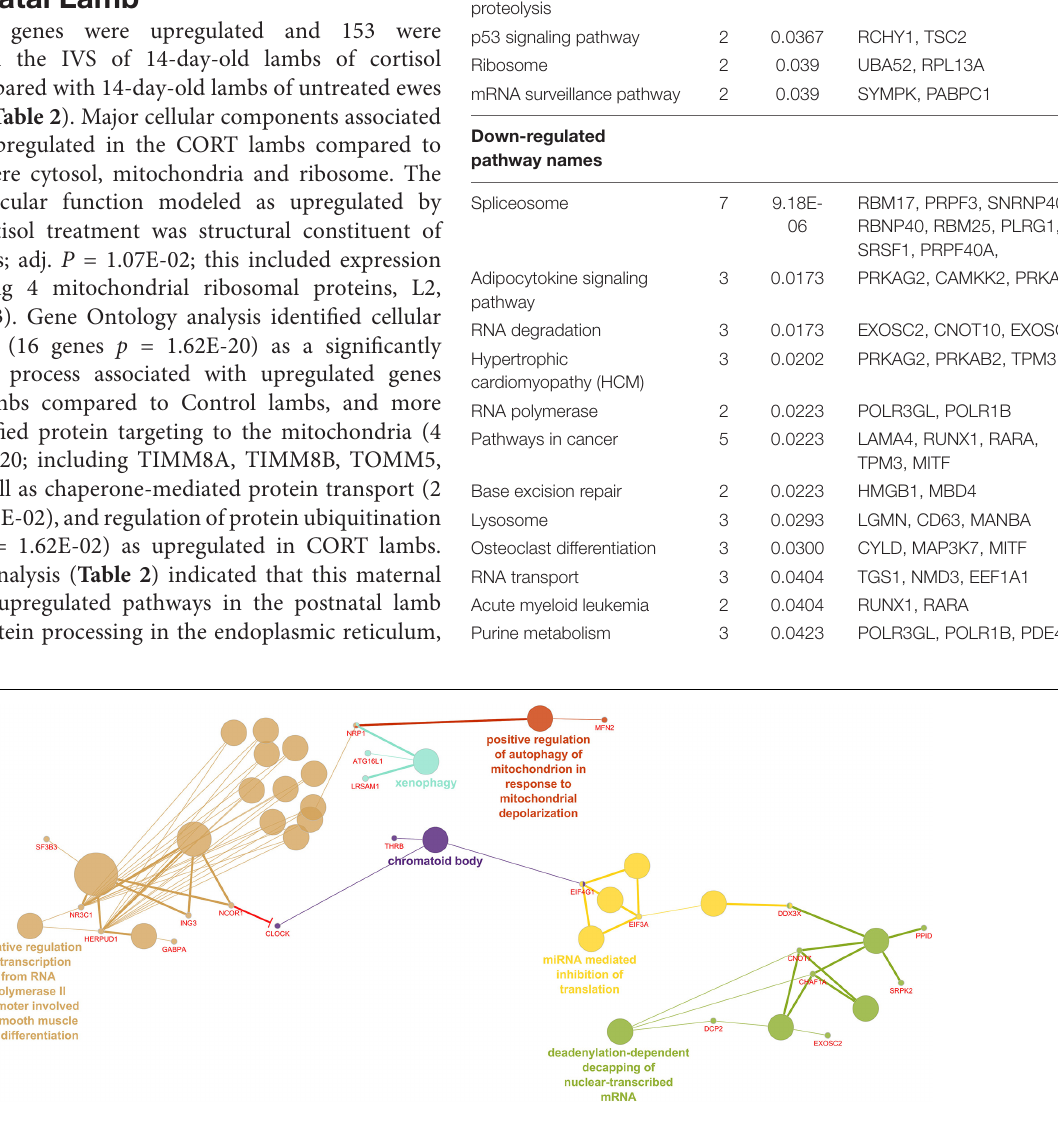
FIGURE 1 | Enriched ClueGO gene network from the left ventricular free wall. Similar gene ontology or KEGG pathway terms are clustered by color and the representative term for those clusters are presented. Gene names shown in red; Red lines with bars represent interactions involved in gene repression.